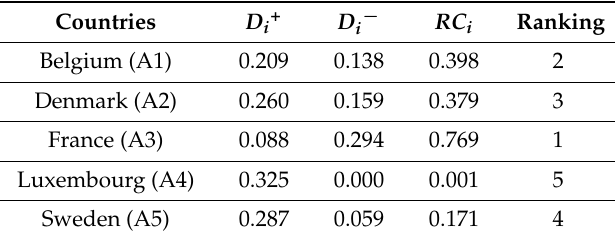
Table 13. Ranking results of the international transport export including energy trade for the selected EU countries in 2013.